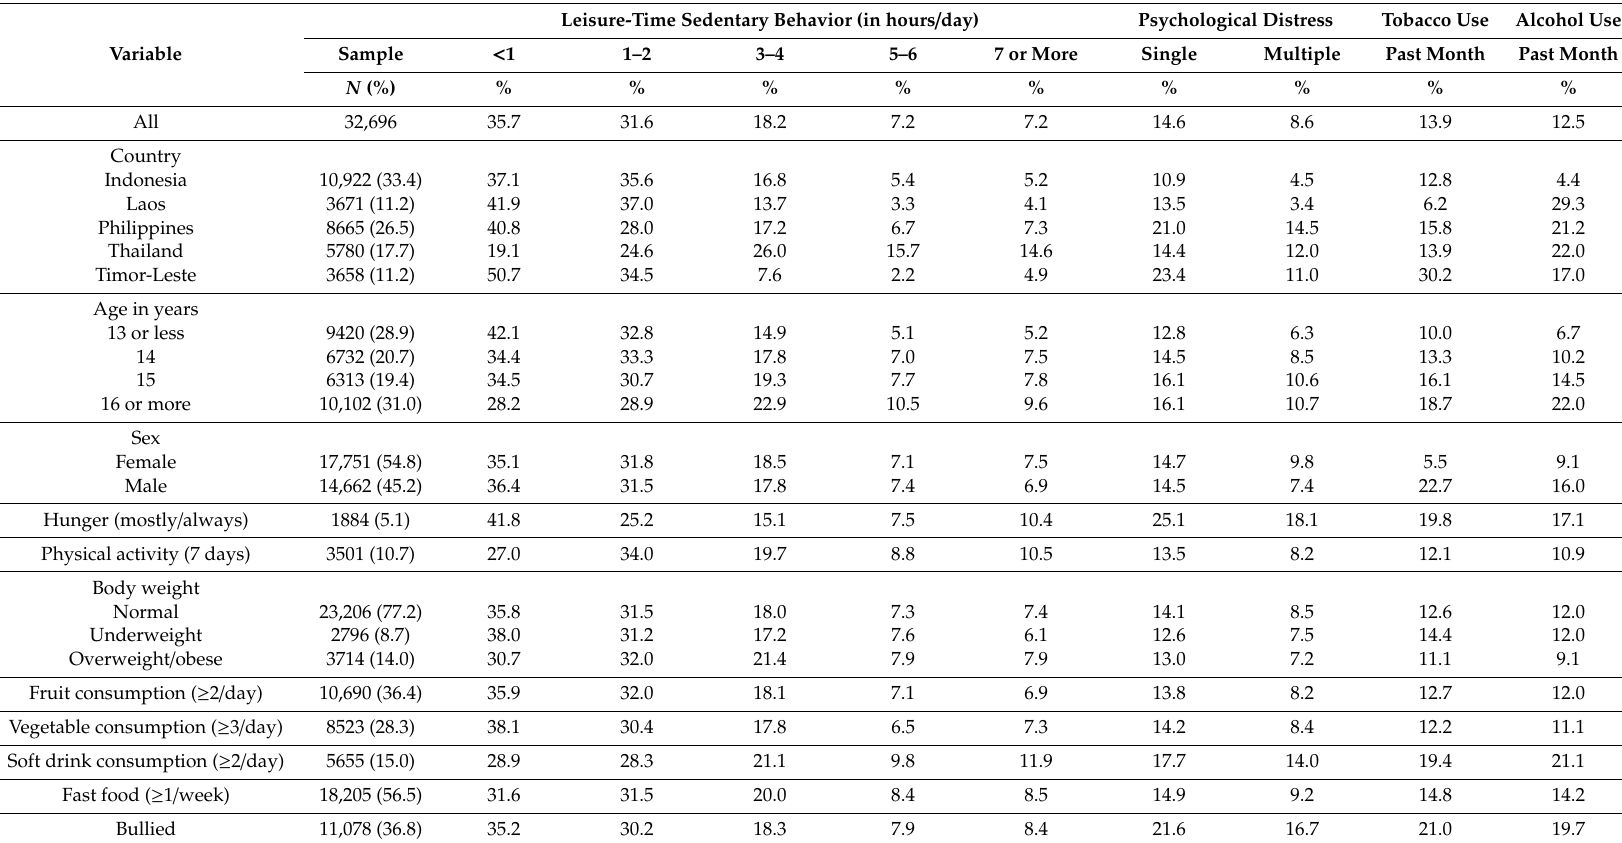
Table 2. Sample characteristics by sedentary behavior, psychological distress and substance